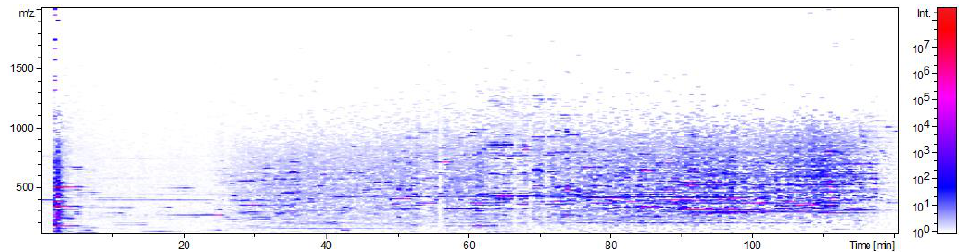
Figure 5. The distribution density of the analyzed chemical profiles in the ion chromatogram of the wild ginseng supercritical CO 2 extract (Russia).